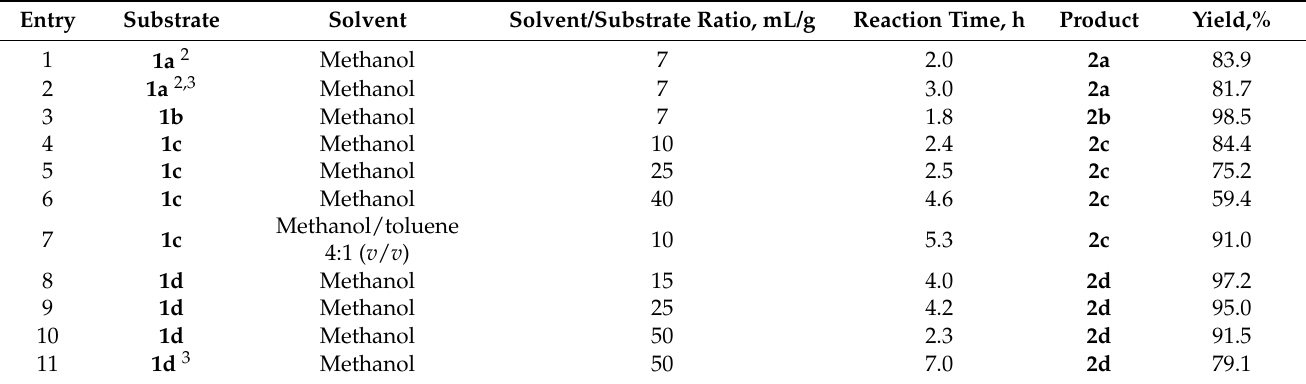
Table 1. Hydrogenation of methyl derivatives of trinitrobenzene in methanol 1 .